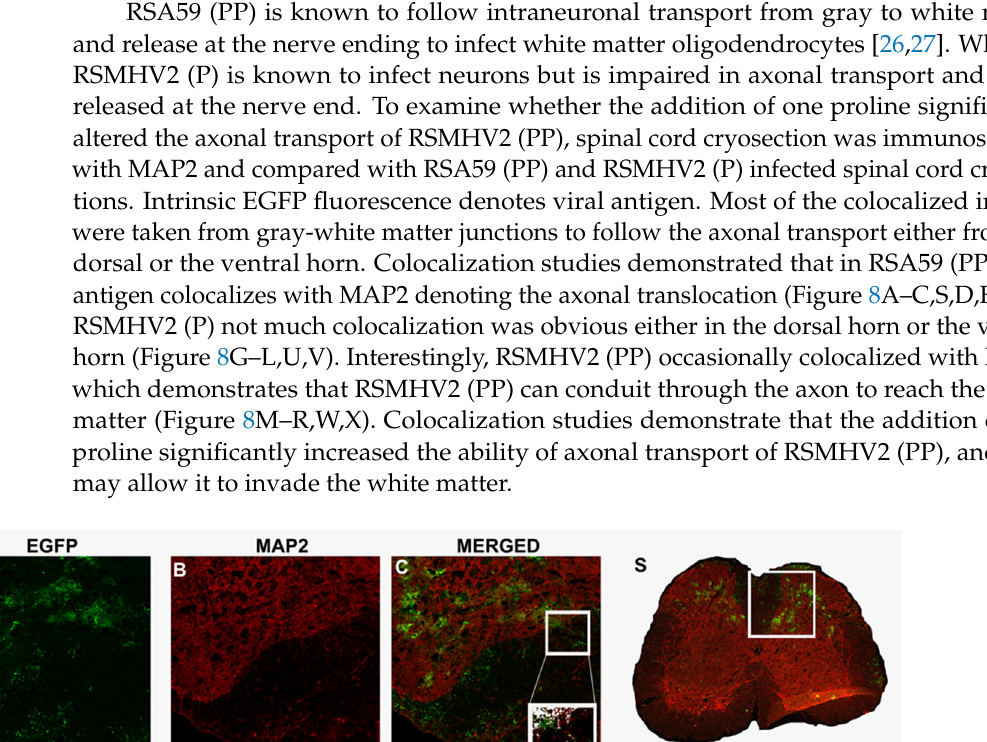
Figure 8. Colocalization of viral antigen with neuronal microtubule marker (MAP2) of RSA59 (PP), RSMHV2 (P), and RSMHV2 (PP) infected spinal cord cryosections . Day 5 post-infected spi- nal cord cryosections immuno-fluorescently labeled with MAP2 (Red) ( B , E , H , K , N , Q ). Intrinsic EGFP fluorescence denotes viral antigen ( A , D , G , J , M , P ). Merged images of EGFP and MAP2 ( C , F , I , L , O , R ). RSA59 (PP) infected spinal cord sections are ( A – F , S , T ), RSMHV2 (P) are from ( G – L , U , V ), RSMHV2 (PP) are ( M – R , W , X ). Dorsal column gray-white matter junctions are in panels ( A – C ) (RSA59 (PP)), ( G – I ) (RSMHV2 (P)), and P-R (RSMHV2 (PP)). The ventral white matter and adja- cent ventral horns from the infected section are shown as RSA59 (PP) ( D , F ), RSMHV2 (P) ( J – L ), RSMHV2 (PP) ( P – R ). The insets in the merged images show magnified views of the co-localization of virus-infected cells with the Anti-MAP2 and dendrites at the gray-white matter junction. In the insets, co-localization is seen as white with infected axons.